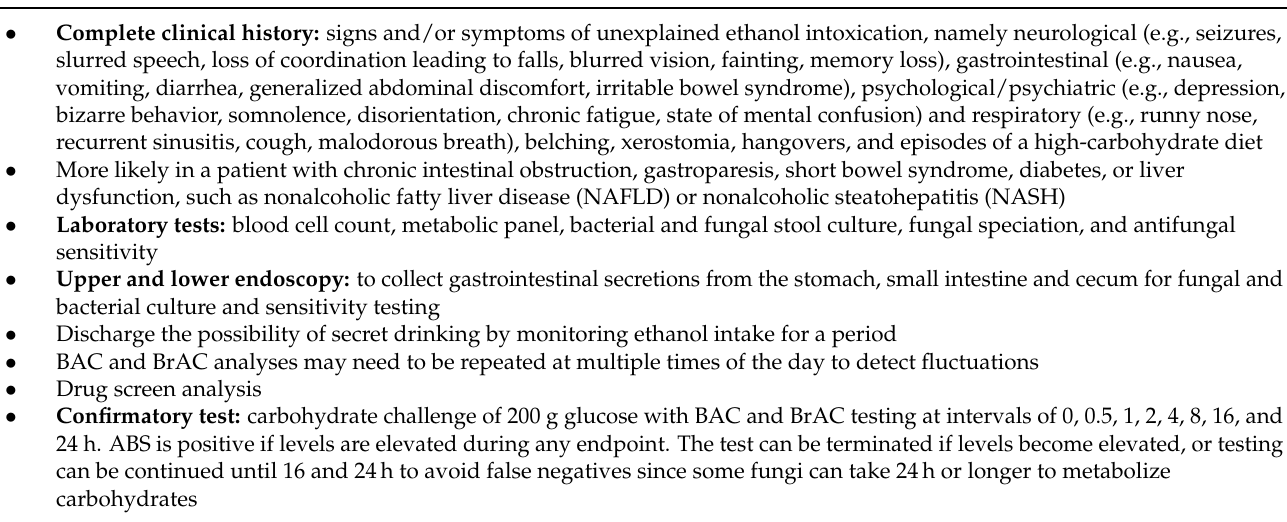
Table 2. Diagnosis of ABS according to [6,22,51,52]. BAC, blood alcohol concentration; BrAC, breath alcohol